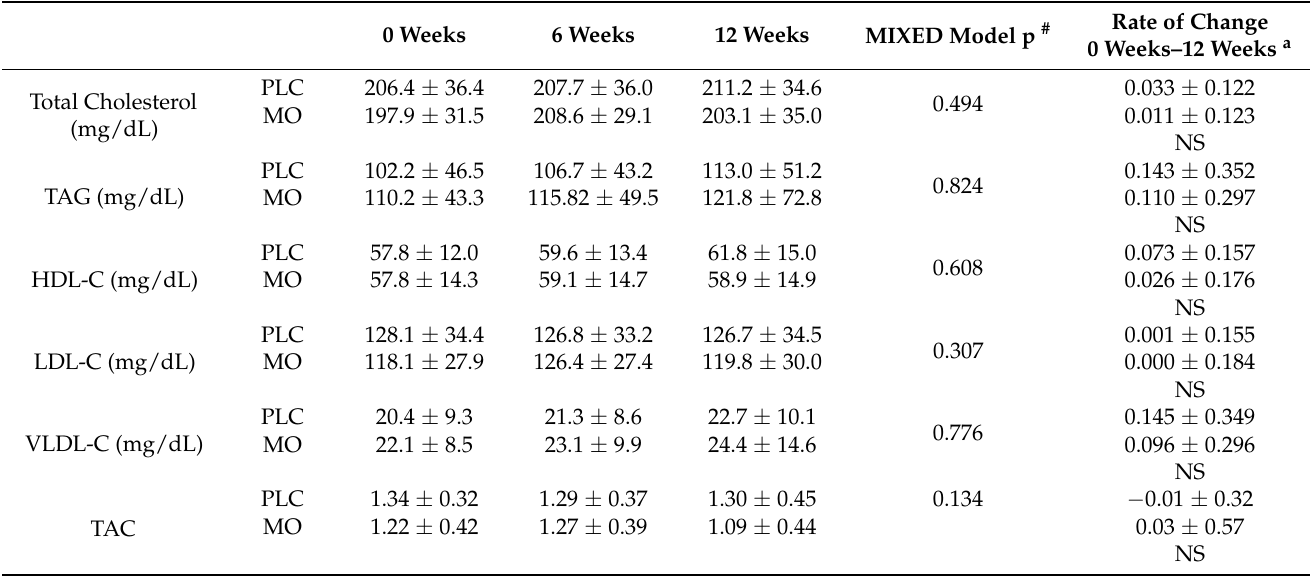
Table 4. Serum lipid profile and plasma TAC in patients with prediabetes of the PLC and MO groups during the